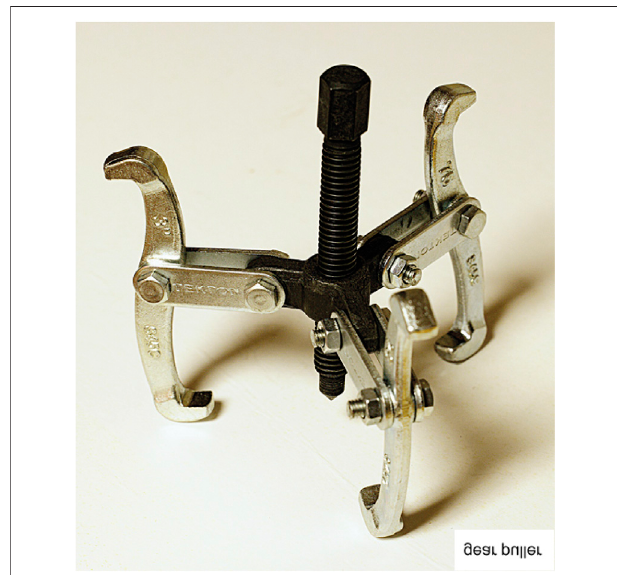
FIGURE 1 | Image of a tool whose function is not obvious from its structure. Its name and function are given in the bottom right corner as a horizontal re fl